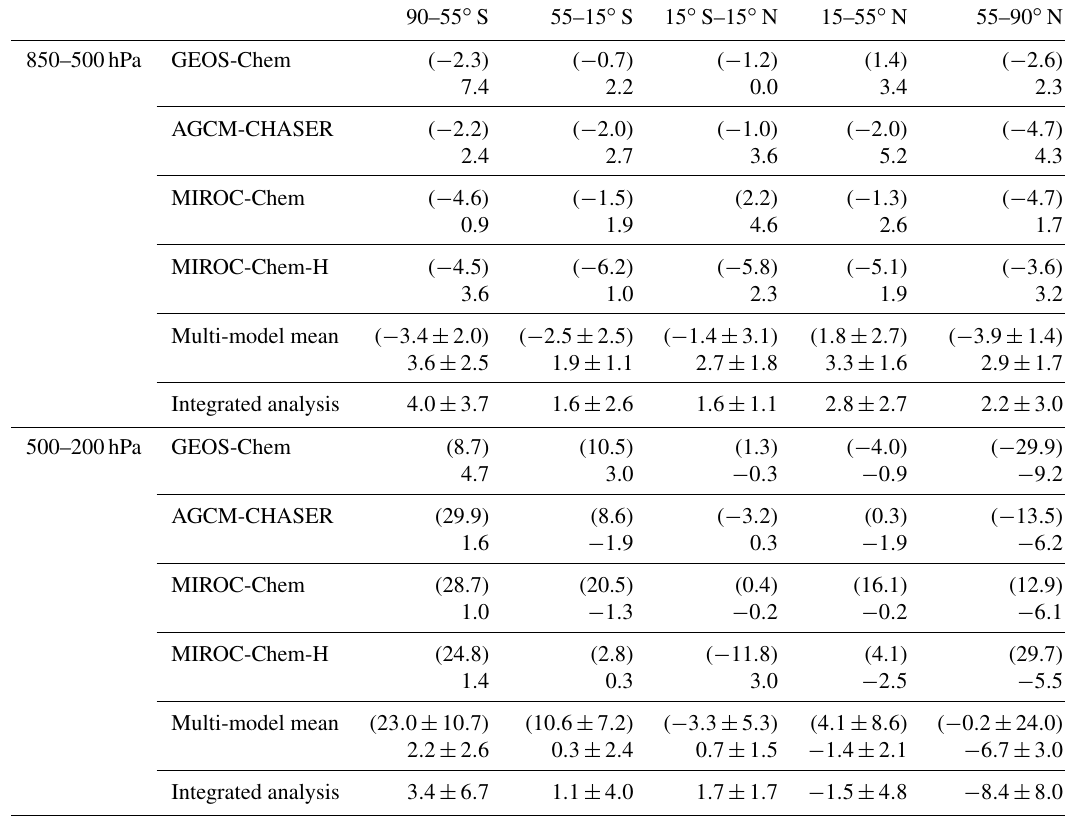
Figure 7. Comparison of seasonal variation in ozone concentration between the ozonesonde observations (black solid line), model simula- tions (colored dotted lines), and data assimilation (colored solid lines) averaged between 90–55 ◦ S, 55–15 ◦ S, 15 ◦ S–15 ◦ N, 15–55 ◦ N, and 55–90 ◦ N for 2007. From top to bottom, results are shown for concentrations averaged over 80–200, 200–500, and 500–850hPa. The ± 1 σ deviation among the four models (i.e., model spread) is shown in gray for the control runs and in light blue for the data assimilation results. Table 2. Annual mean bias of the mean ozone concentrations (ppbv) between the data assimilation or control run (in brackets) and the ozonesonde observations from the WOUDC network for 850–500 and 500–200hPa in parts per billion for five latitudinal bands, SH high The results are shown for individual models, multi-model mean (mean ± 1 σ ), and integrated analysis ( x m ± σ 2 m